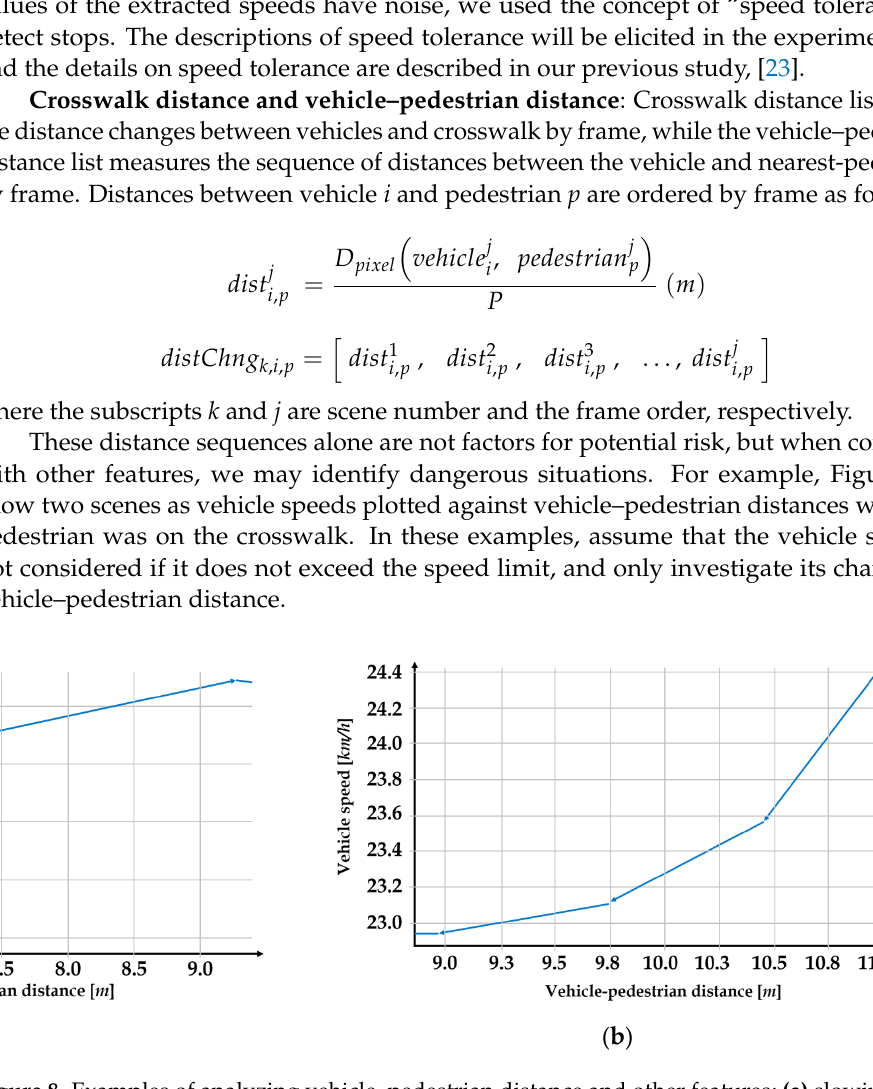
Figure 8. Examples of analyzing vehicle–pedestrian distance and other features; ( a ) slowing down and dramatically accelerated; and ( b ) normal slowing down when approaching to pedestrian Relative position change between vehicles and pedestrians : This describes the positional relationship between vehicles and pedestrians. If a pedestrian is in front of the car, they are at greater risk than if they were behind the car. We determine the relative positions between them by comparing their contact points, along with the position and direction of the vehicles.